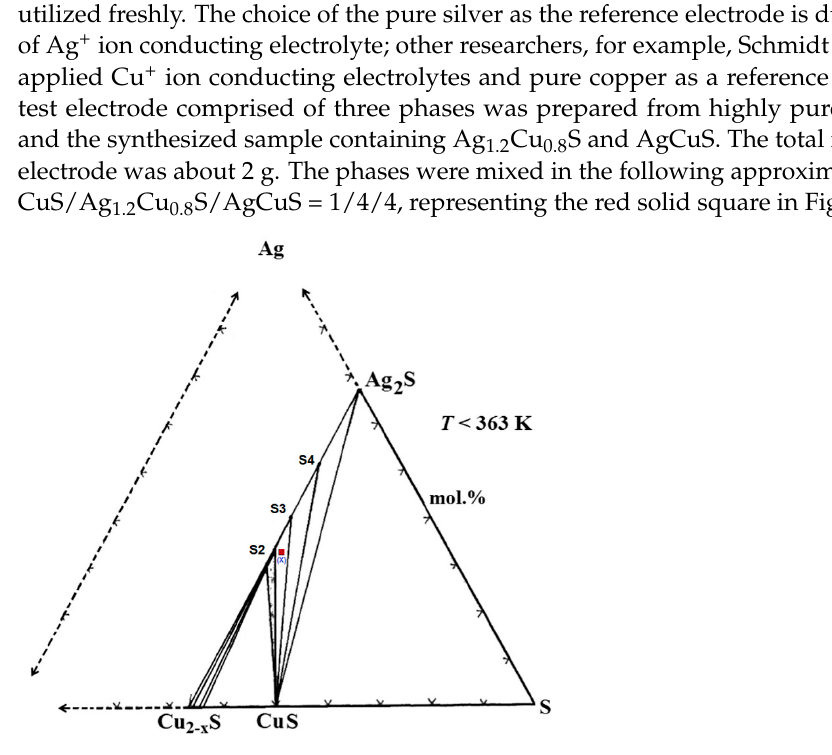
Figure 3. A portion of isothermal phase diagram of the ternary Ag-Cu-S system, below 363 K (illustrated based on the information provided in [4]). Notations: S2 is Ag 0 . 93 Cu 1 . 07 S (ortho), S3 is Ag 1 . 2 Cu 0 . 8 S (ortho), S4 is Ag 1 . 55 Cu 0 . 45 S (bct), and (x) is composition of the cathode material.